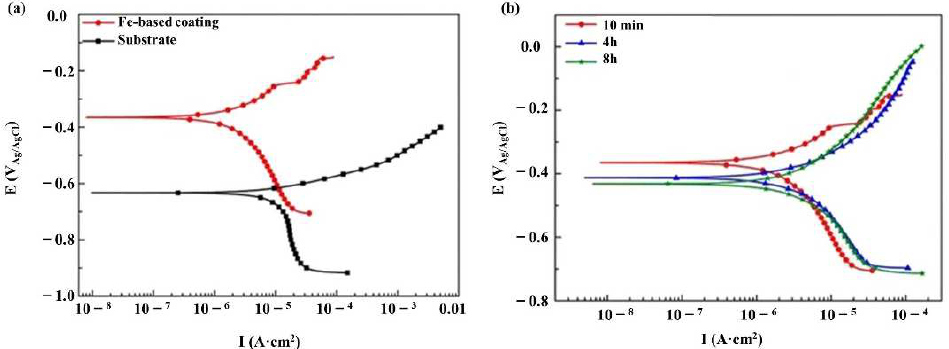
Figure 24. Potentio-dynamic polarization curves of the Fe-based coating with various immersion times in 3.5 wt.% NaCl solution: ( a ) 10 min immersion time; ( b ) 10 min, 4 h, 8 h immersion time [118].